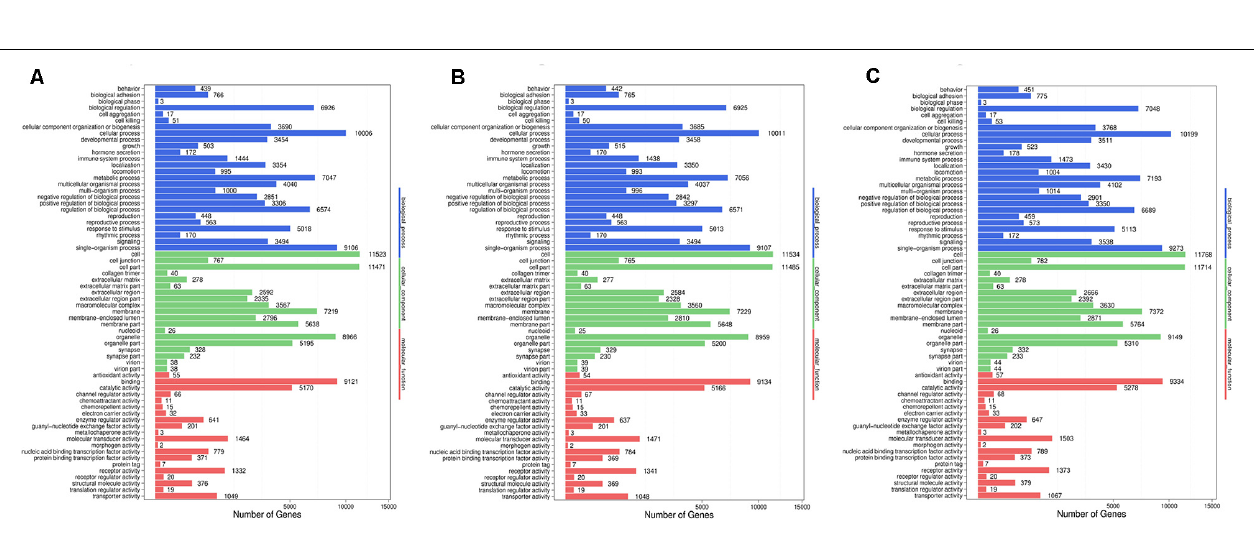
Frontiers in Genetics |